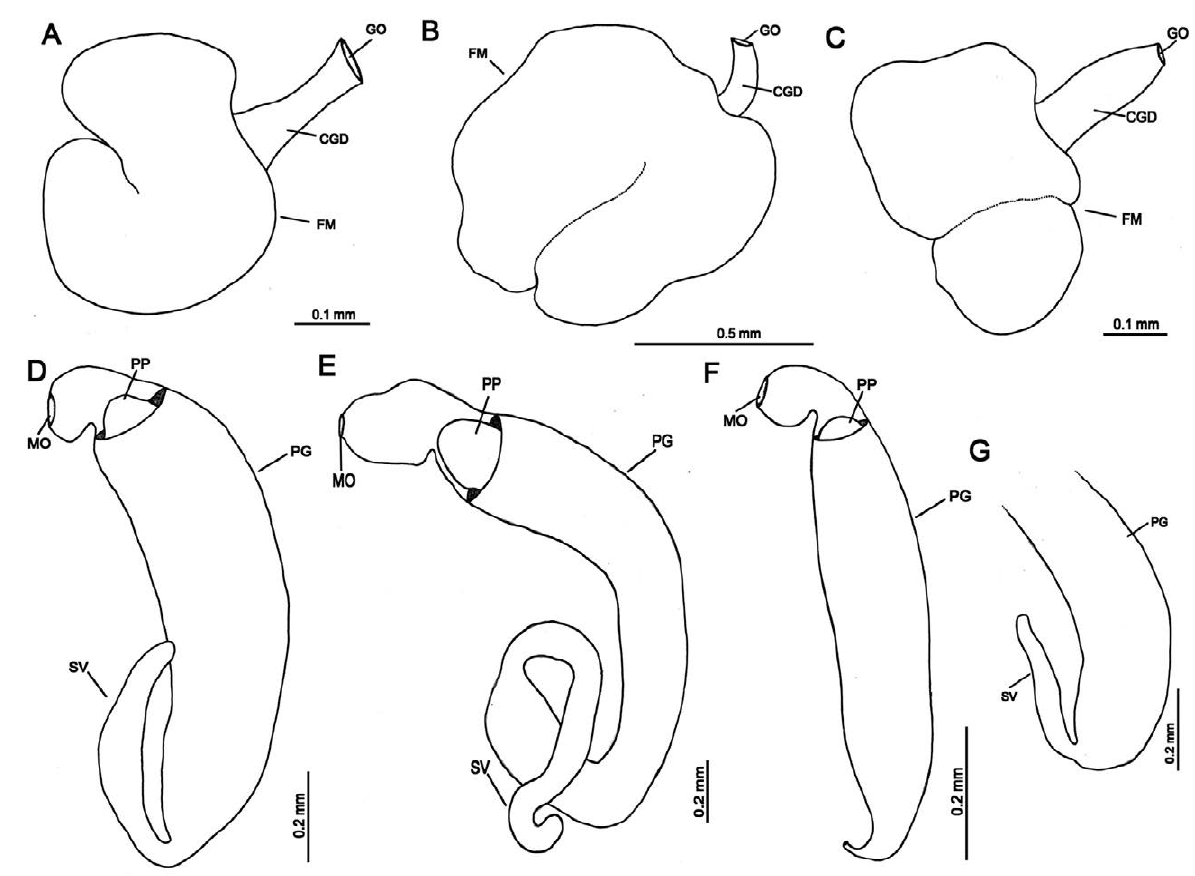
Fig. 6. – Reproductive system of Runcina species. Top row female part (A, B, C) and lower row male part (D, E, F, G). A, D, R. brenkoae , Croatia (MNCN 15.05/88088); B, E, R. lusitanica n. sp., Portugal (MNCN 15.05/88093); C, G, R. marcosi n. sp., Cádiz, Spain (MNCN 15.05/200066), male copulatory organ damaged without penial papilla, but showing seminal vesicle; F, R. marcosi n. sp., Catalonia, Spain (MNCN 15.05/88097), male copulatory organ damaged without seminal vesicle. Abbreviations: fm, female mass; cgd, common genital duct; go, gonopore; mo, male opening; pp, penial papilla; pg, prostate gland; sv, seminal